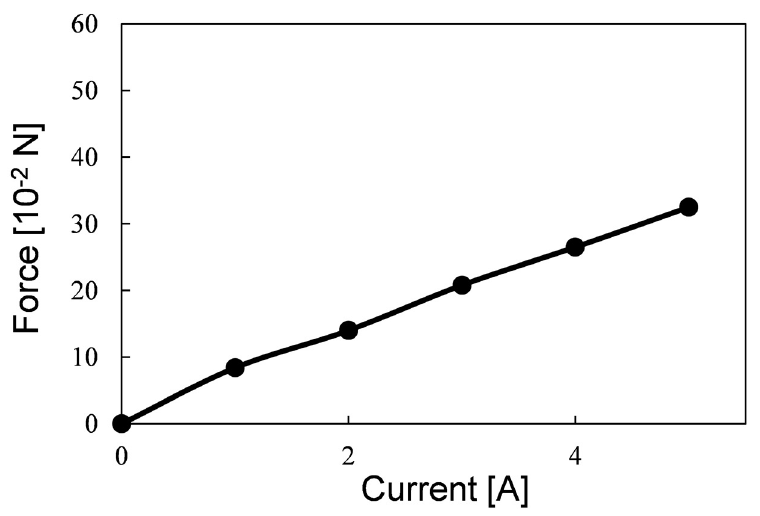
Figure 11. Relationship between attractive force and applied current to copper coils.